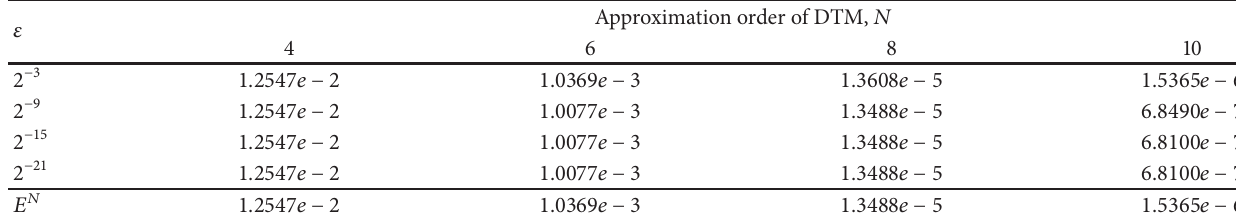
Table 4: Maximum pointwise errors 𝐸 𝑁 𝜀 and 𝐸 𝑁 for the solution 𝑦 1, ap of Example 2.